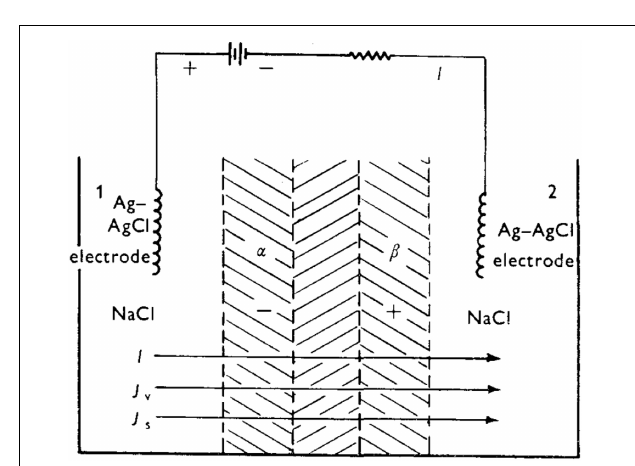
FIGURE 7 | Experimental set-up of Shashoua (1967) leading to a rapid succession of spike oscillations. From Katchalsky and Spangler (1968).